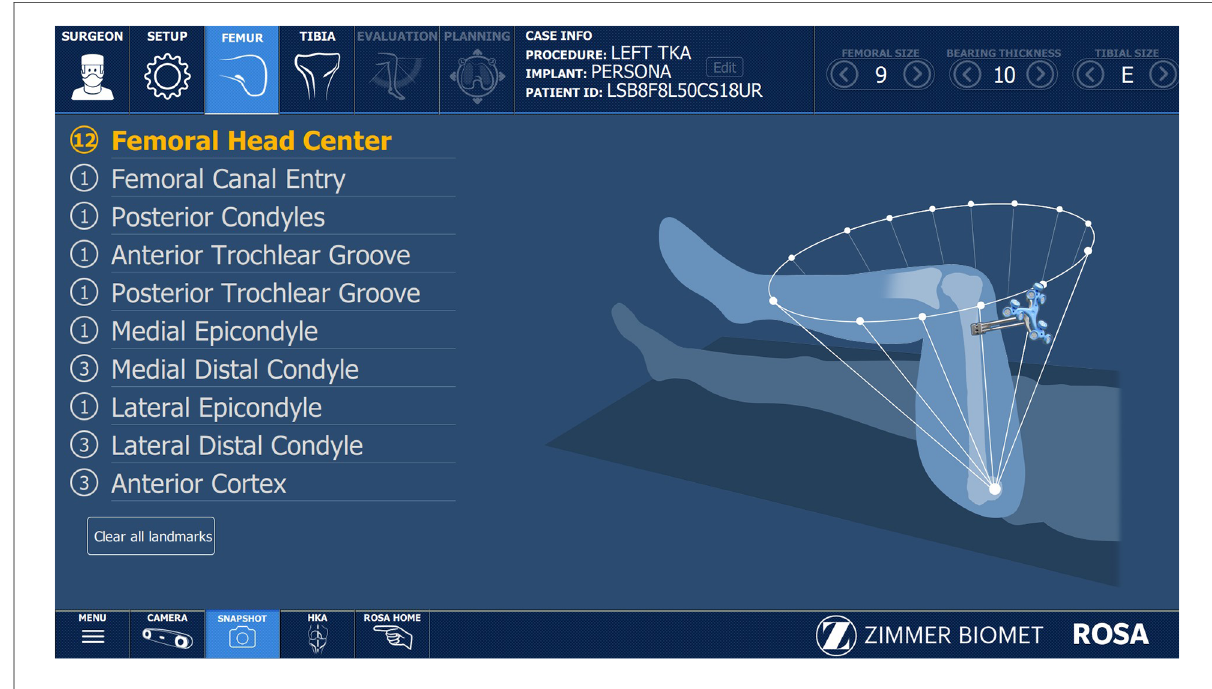
FIGURE 1 Registration screen displaying the work fl ow for the required femoral anatomic